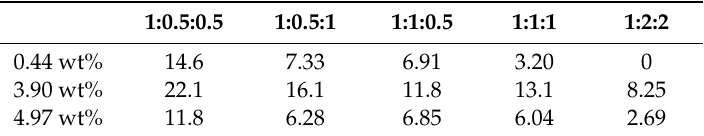
Table 6. Comparison of the maximum molar quantity of CH 4 per unit weight of photocatalyst with illumination time among di ff erent molar ratios of CO 2 / H 2 / H 2 O and Pd loading weight with UV light illumination (unit: µ mol / g).